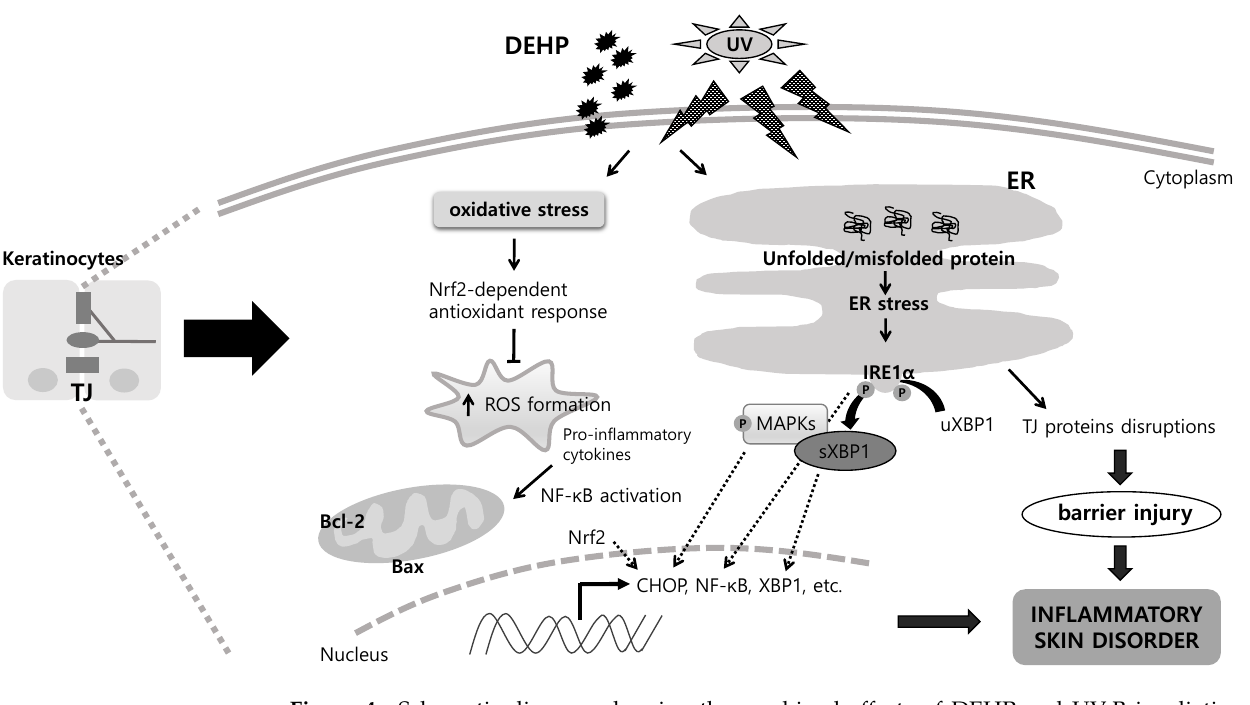
Figure 4. Schematic diagram showing the combined effects of DEHP and UV-B irradiation in HaCaT keratinocytes. As depicted, DEHP and UV-B induced ER stress results in IRE1-mediated development of pathologic conditions such as apoptosis and inflammation, which in turn contributed to TJ disruption. The → indicates activation or induction, and (cid:97) indicates inhibition or